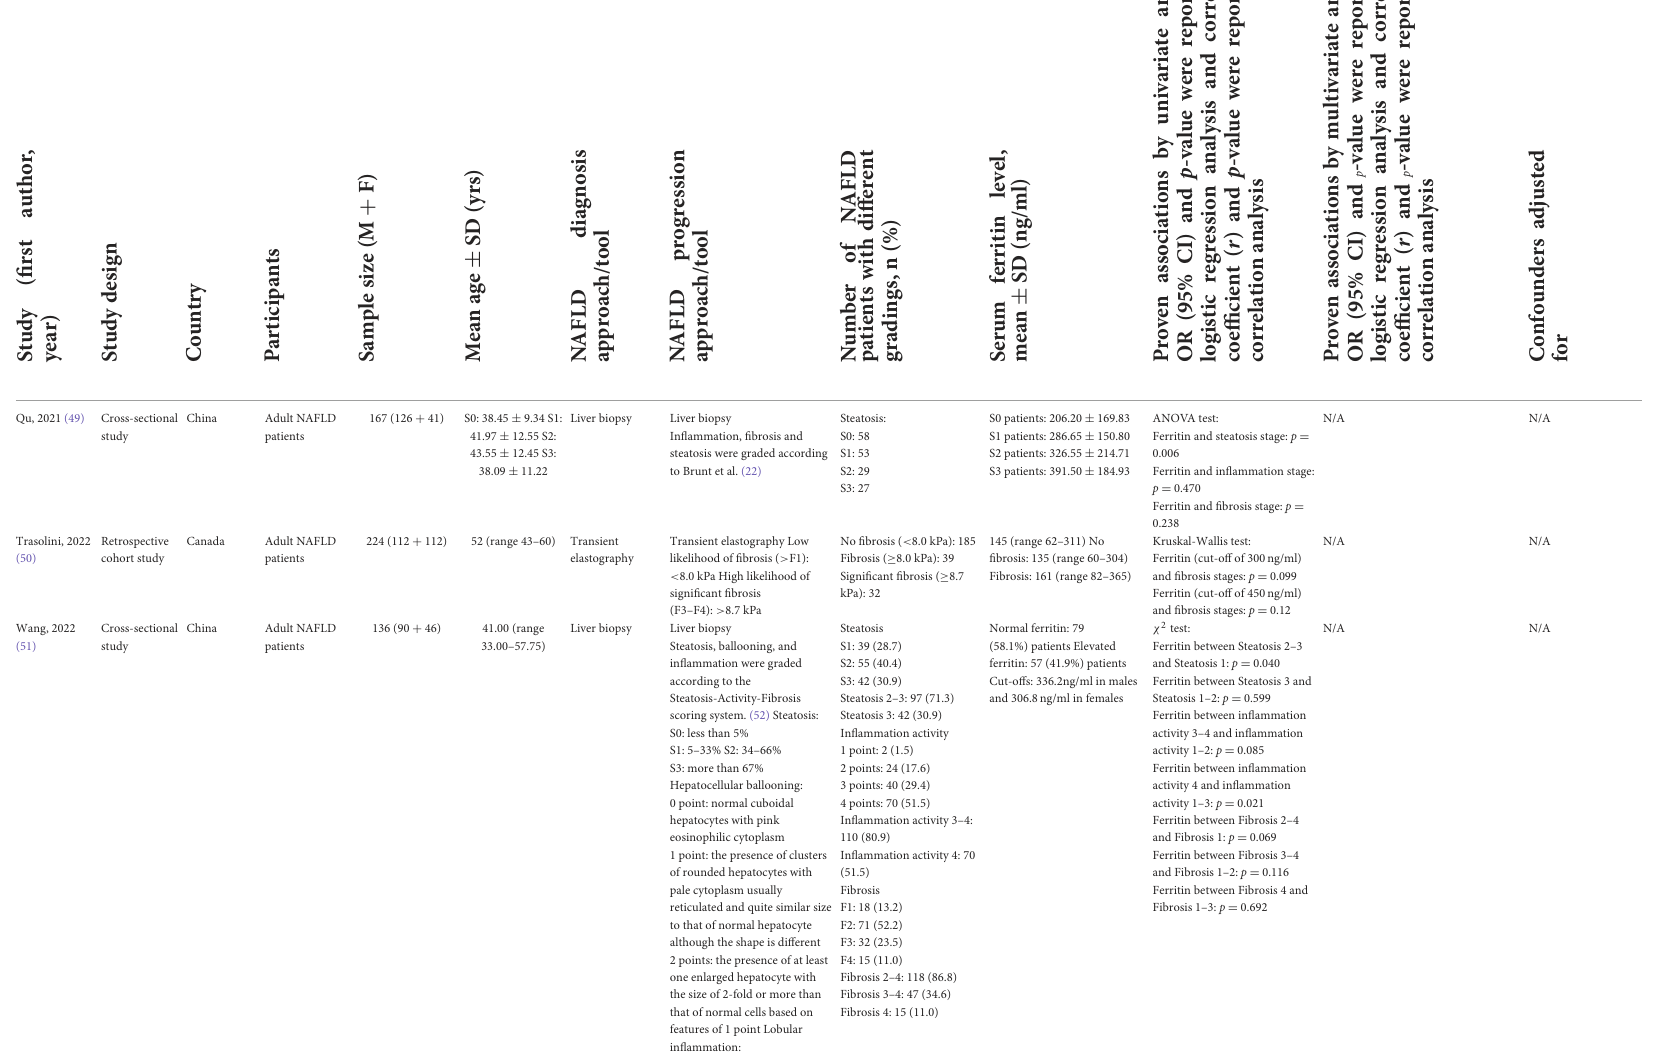
andFibrosis1: p = 0.069 FerritinbetweenFibrosis3–4 andFibrosis1–2: p = 0.116 FerritinbetweenFibrosis4and Fibrosis1–3: p =